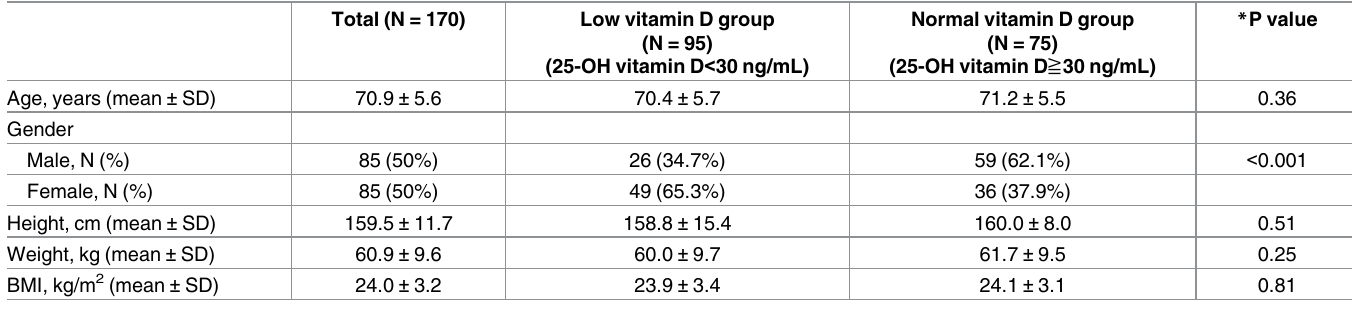
Table 1. Comparison of demographic and anthropometric characteristics between low and normal vitamin D